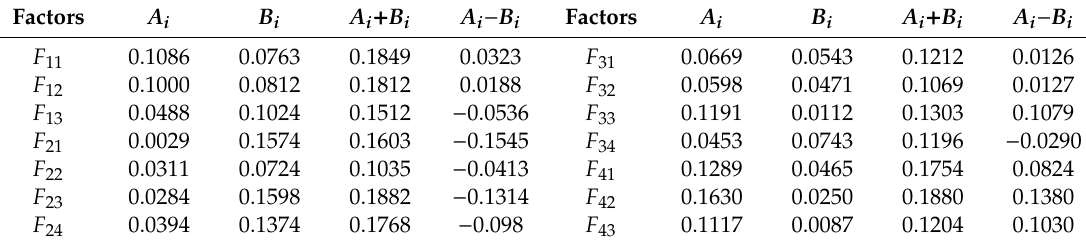
Table 5. The calculations of the matrix M